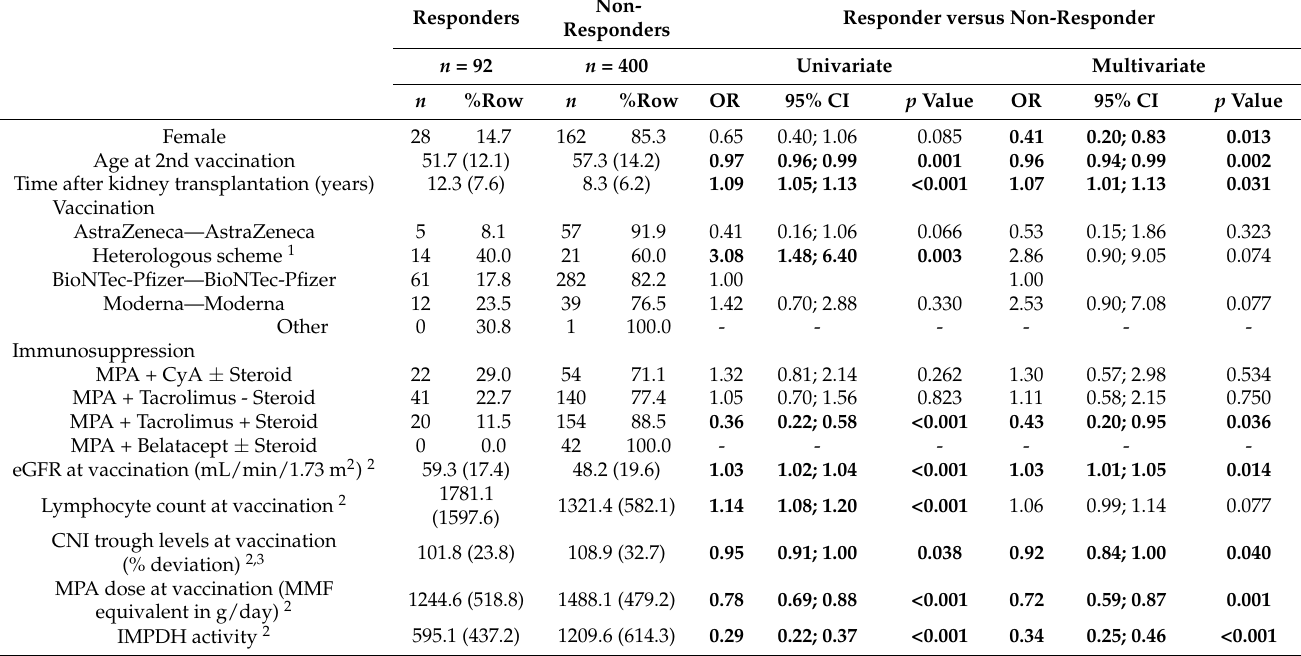
Table 3. Univariate and multivariate analysis of factors associated with serological response to SARS-CoV-2 vaccination in MPA-treated patients after kidney